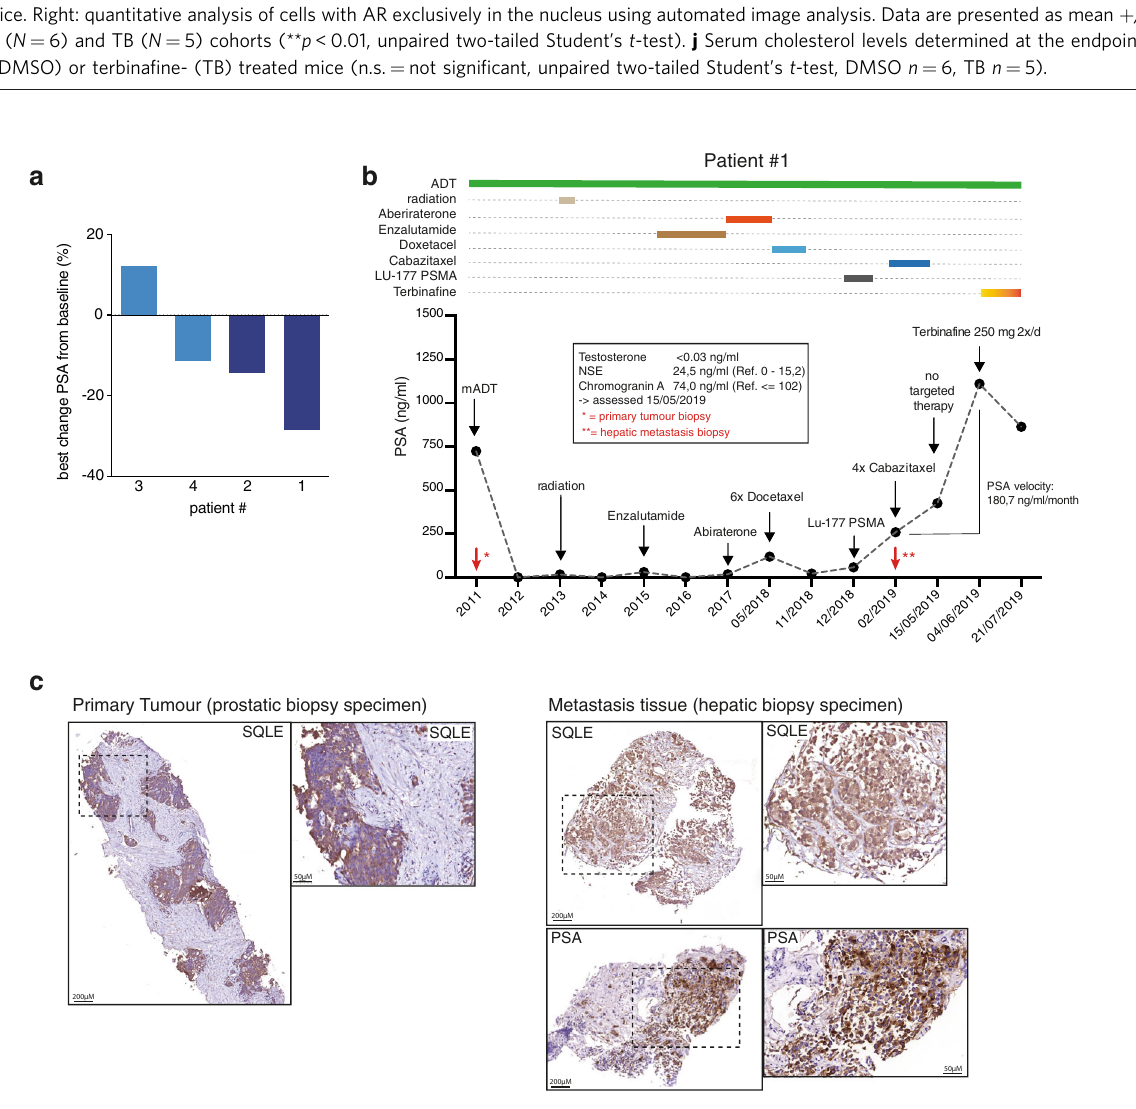
Fig. 7 SQLE inhibition suppresses tumour growth in an orthotopic mouse model of PCa. a Study design of the orthotopic xenograft model used. b Time course of serum prostate-speci fi c antigen (PSA) levels in vehicle- (DMSO, red line) or terbina fi ne (TB, blue line) treated mice at the indicated time points after orthotopic xenografting of VCaP cells. Data are presented as mean + / − SD of DMSO ( N = 8) and TB ( N = 7) cohorts. (** p < 0.01, unpaired two- tailed Student ’ s t -test). c Tumour volume in vehicle- (DMSO, red line) or terbina fi ne- (TB, blue line) treated mice at the indicated time points after